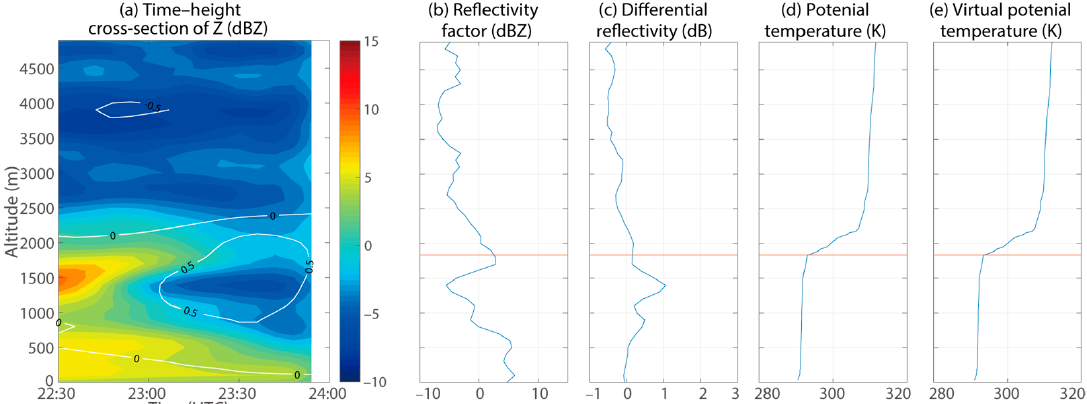
Figure 17. Time–height cross-section of the Z values ( a ) from 22:30 to 24:00, and the vertical profiles of the radar products ( b , c ) and rawinsonde products ( d , e ) at 23:15 UTC on 2 May 2021. The profiles of ( d , e ) are measured by rawinsondes. The estimated entrainment layer is based on the maximum vertical gradient in each variable (orange line).